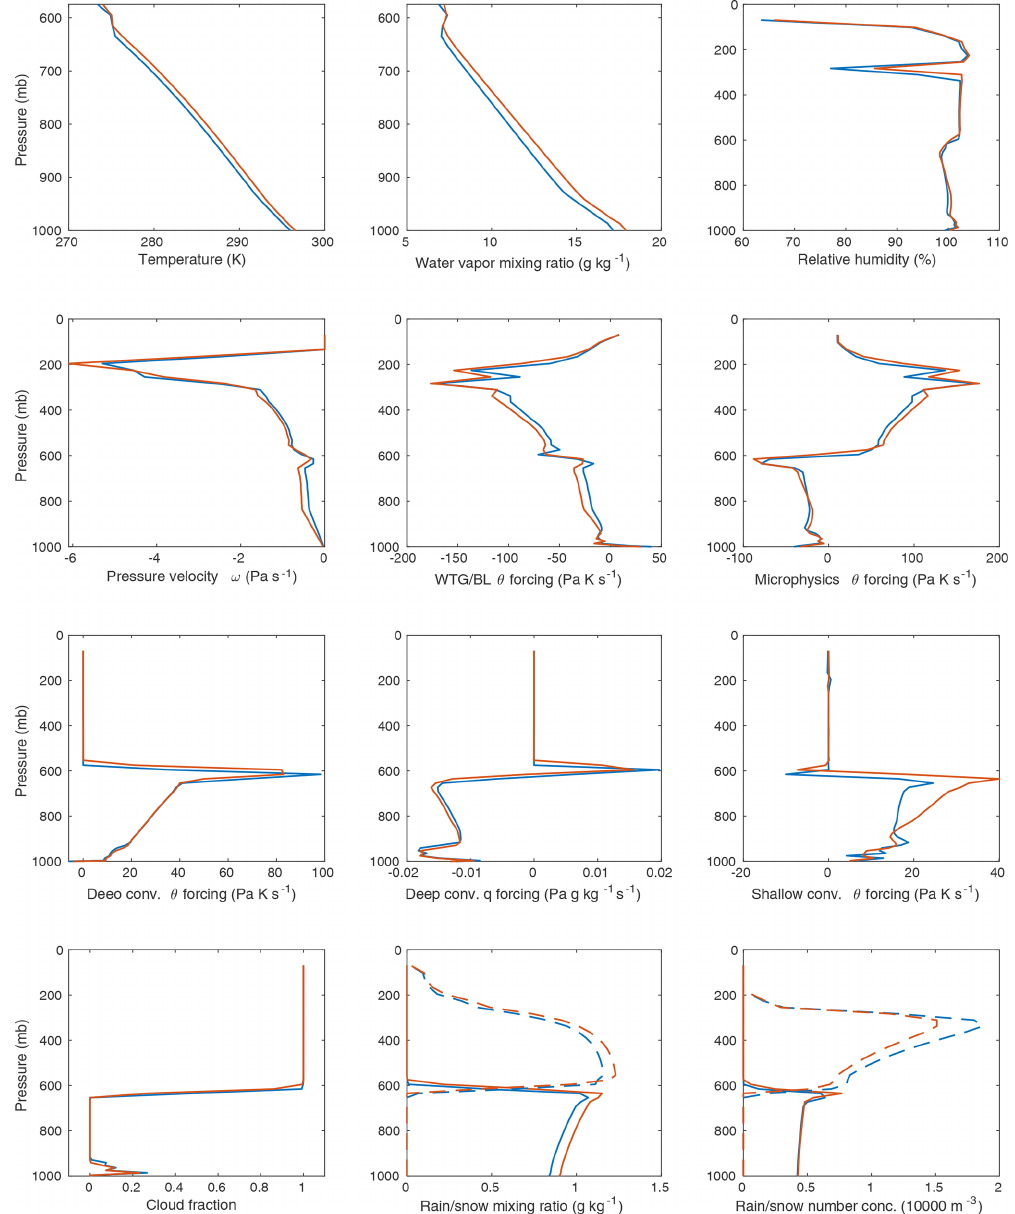
Figure 4. Average profiles for a number of variables for two SCM solutions at SST 304.5K. Blue represents E1 (the equilibrium obtained during the warming phase), and red represents E2 (the cooling phase equilibrium). Forcing terms are mass-weighted in WRF, hence the units of pascals times kelvin per second. Note that the WTG forcing is combined with the boundary layer forcing here, but this quantity is dominated by the WTG forcing above the boundary layer. In the plots for rain or snow mixing ratio and number concentration, solid lines represent rain, and dashed lines represent snow. See also Table